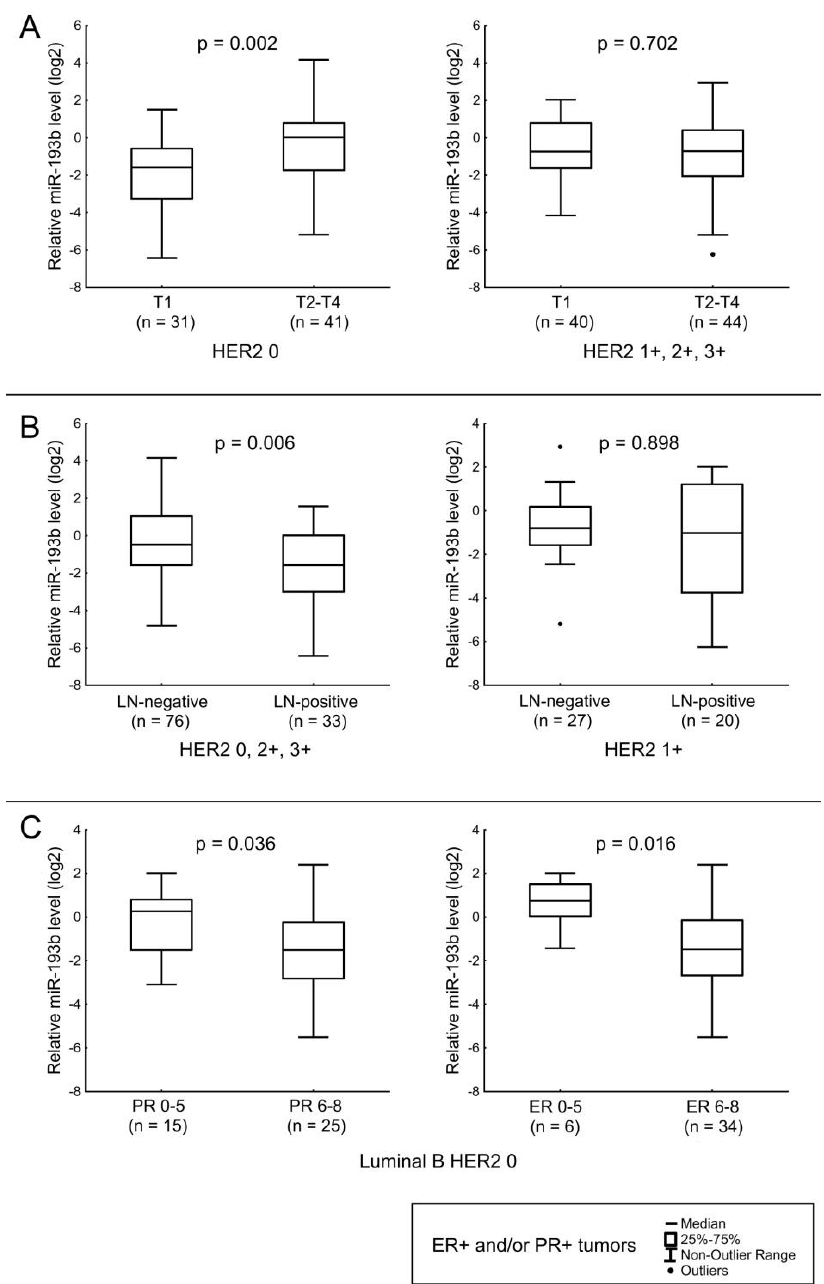
Figure 5. The comparison of miR-193b expression between different cancerous tissue groups: ( A ) relation of miR-193b level with the T stage in tumors with HER2 IHC score 0 (left), relation of miR-193b level with the T stage in tumors with HER2 IHC score 1+, 2+, 3+ (right); ( B ) relation of miR-193b level with LNM in tumors with HER2 IHC score 0, 2+, 3+ (left), relation of miR-193b level with LNM in tumors with HER2 IHC score 1+ (right); ( C ) relation of miR-193b level with PR and ER expression levels in luminal B HER2 0 BC. The Y axis presents the expression level ( log 2 2 –ΔΔCt ); the results were normalized to the control (normal tissue).